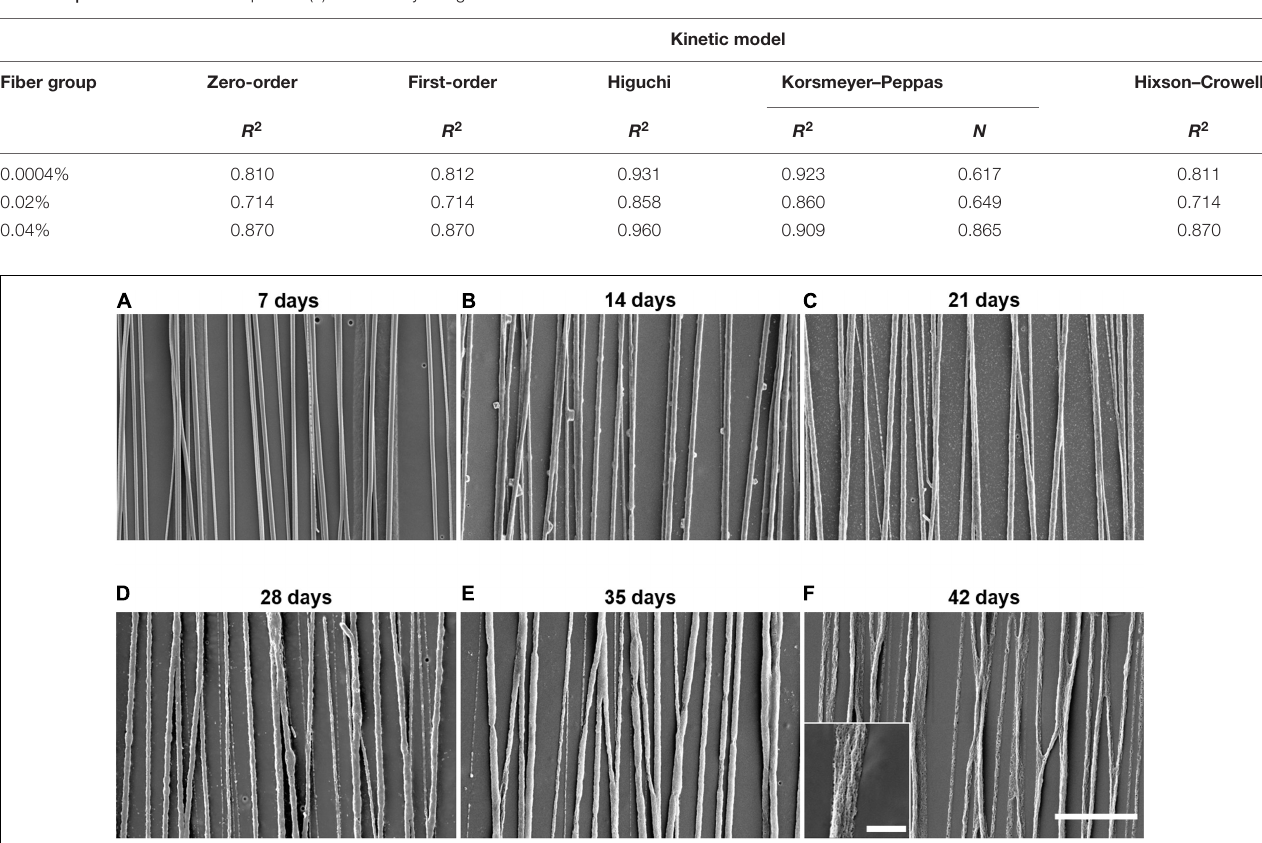
TABLE 5 | The R 2 and release exponent ( n ) obtained by fitting the kinetic models to the release data.